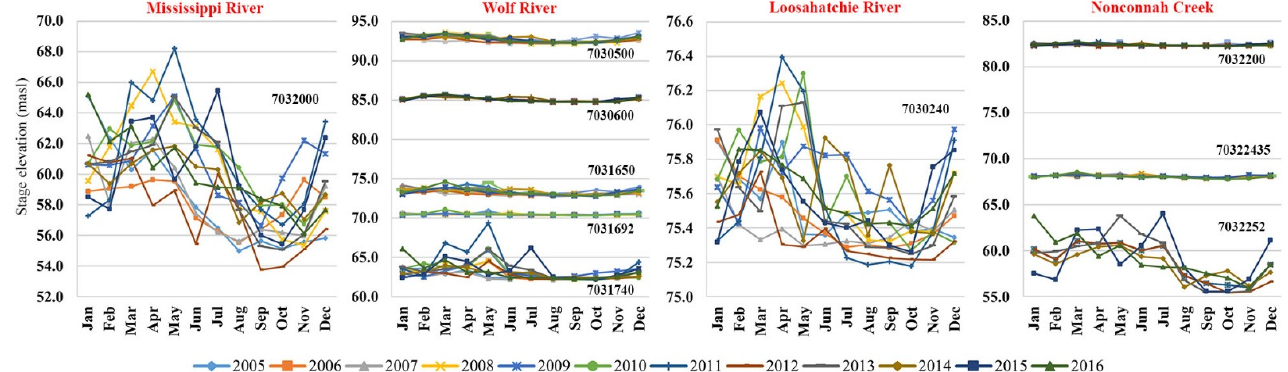
Figure 7. Monthly mean stage elevation at the river gauging stations.